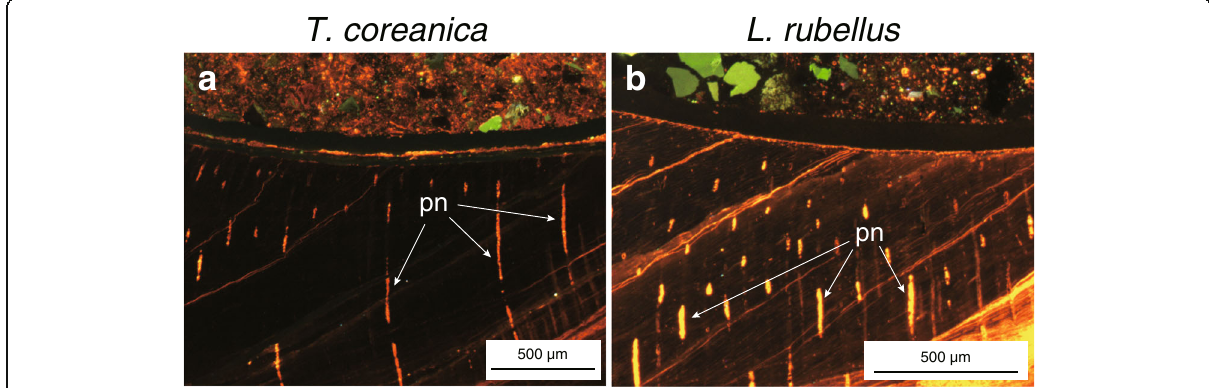
Fig. 5 CL images of puncta-filling cements. CL images of the vertical sections through the studied brachiopod shells ( a Terebratalia coreanica , MNTCo2; b Laqueus rubellus , MNLR2). Note that strongly luminescent dots and lines each corresponding to a calcite cement filling a